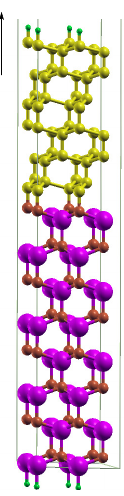
Figure 3. Slab model of the diamond–GaN heterostructure with the abrupt N-C interface type in the [111] growth direction. Large violet and small brown balls represent Ga and N atoms, correspond- ingly. Small yellow balls and tiny green balls represent C atoms and terminating H pseudoatoms,